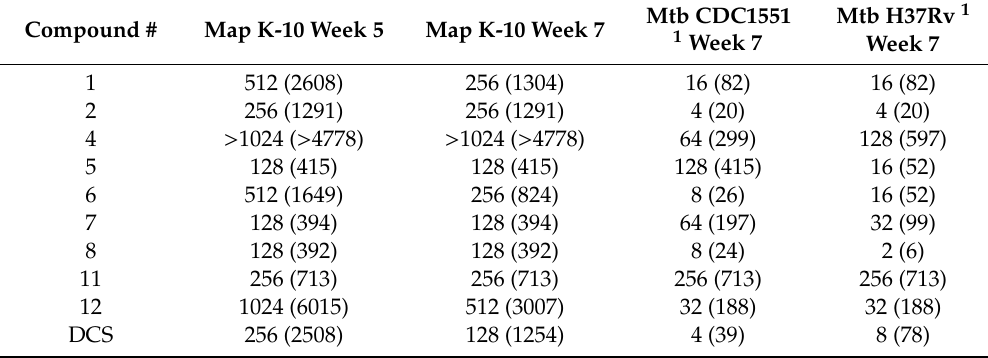
Table3. MICs[ µ g / ml( µ M)]against Mycobacteriumtuberculosis (Mtb)and Mycobacteriumavium subspecies paratuberculosis